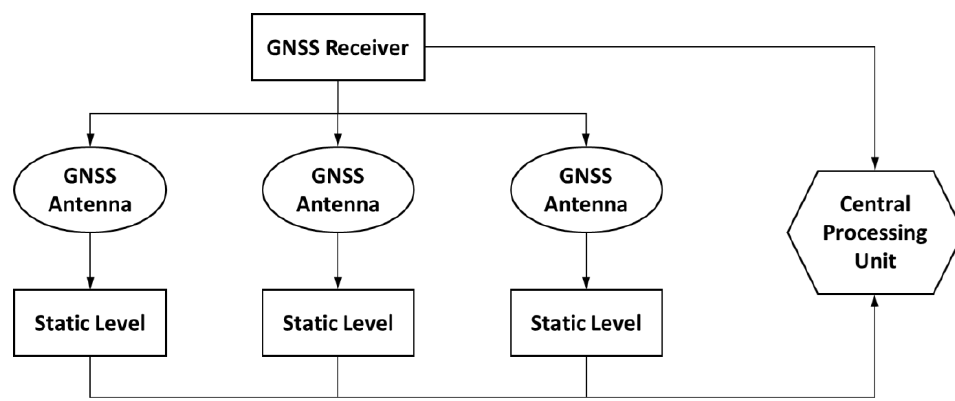
Figure 4. System structure drawing.